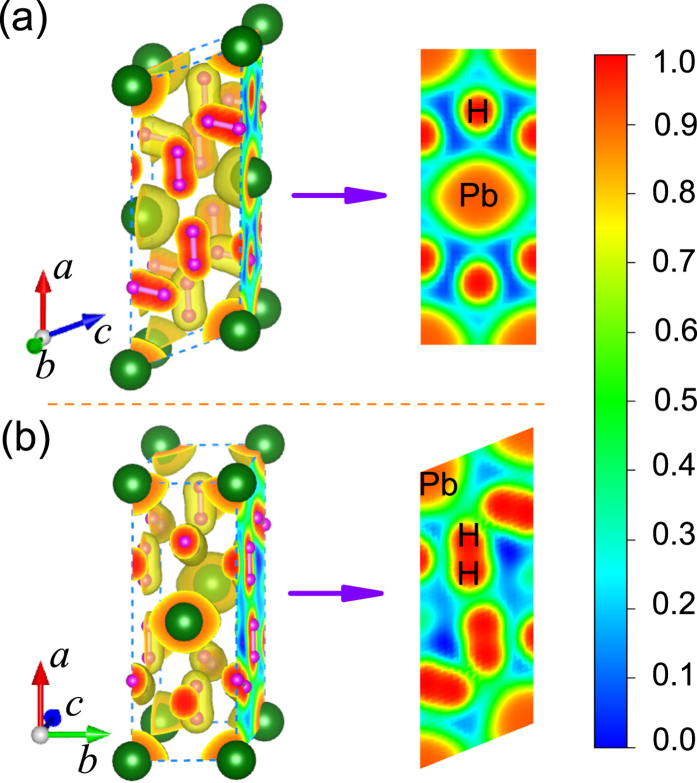
ELF of PbH4(H2)2.Calculated ELF isosurface of PbH4(H2)2 for C2/m at 200 GPa with the ELF value of 0.75. (a,b) highlight the sections on (001) and (010) planes, respectively.